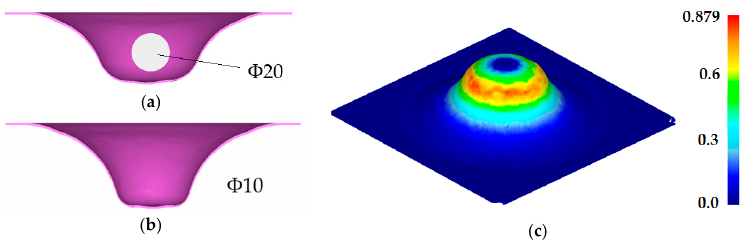
Figure 5. ( a ) Meshing zones considered and ( b ) boundary conditions (clamped condition in “red”).